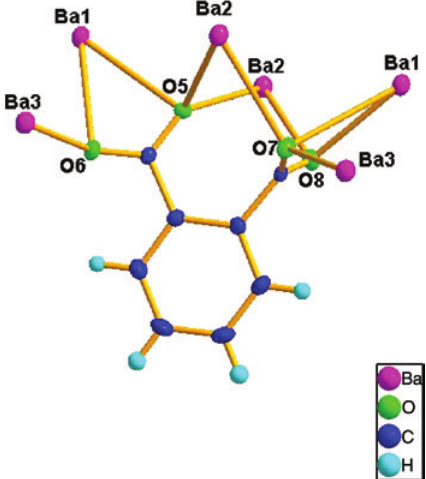
O rings present in 2 2